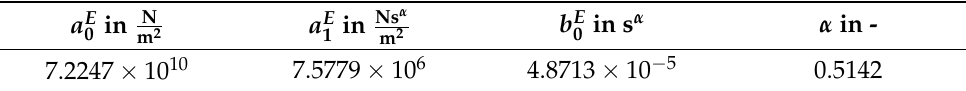
Table 11. List of the fractional derivative parameters—test object.